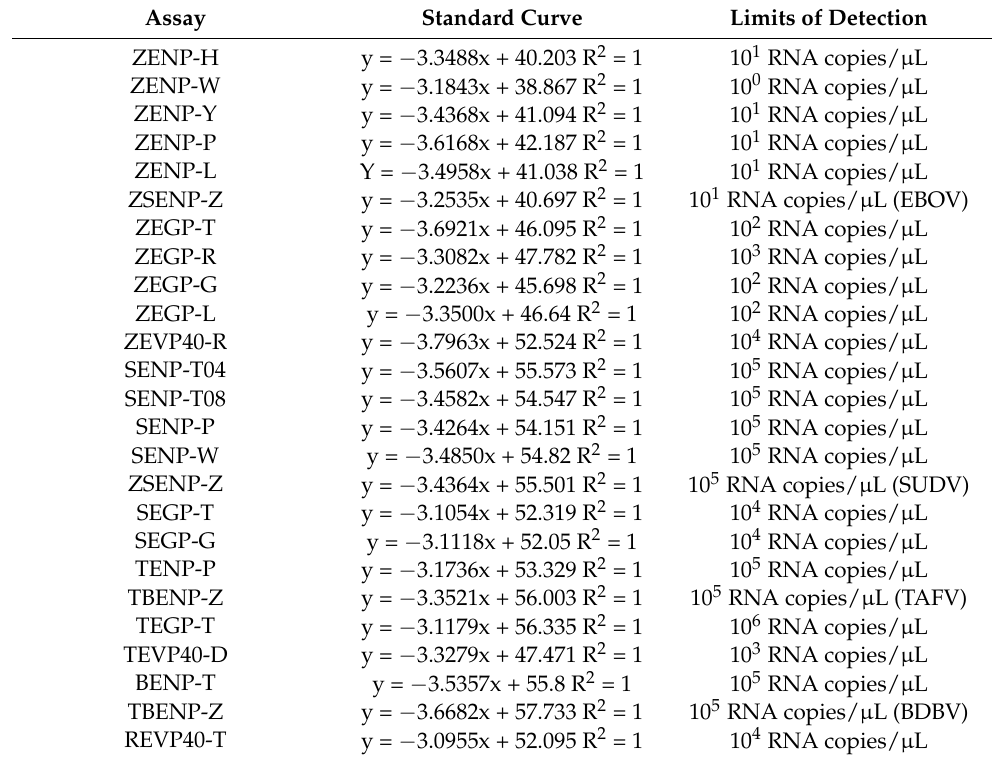
Table 2. The standard curves and detection limits of TaqMan RT-PCR assays for different ebolavirus species. Amplification plots were realized on 10-fold dilutions of known concentration of transcript RNAs containing the CDS of NP, GP or VP40 from each species of ebolavirus. From the obtained standard curves, the sensitivity for each assay was also determined. ( x stand for Log copies/ µ L and y stand for Ct